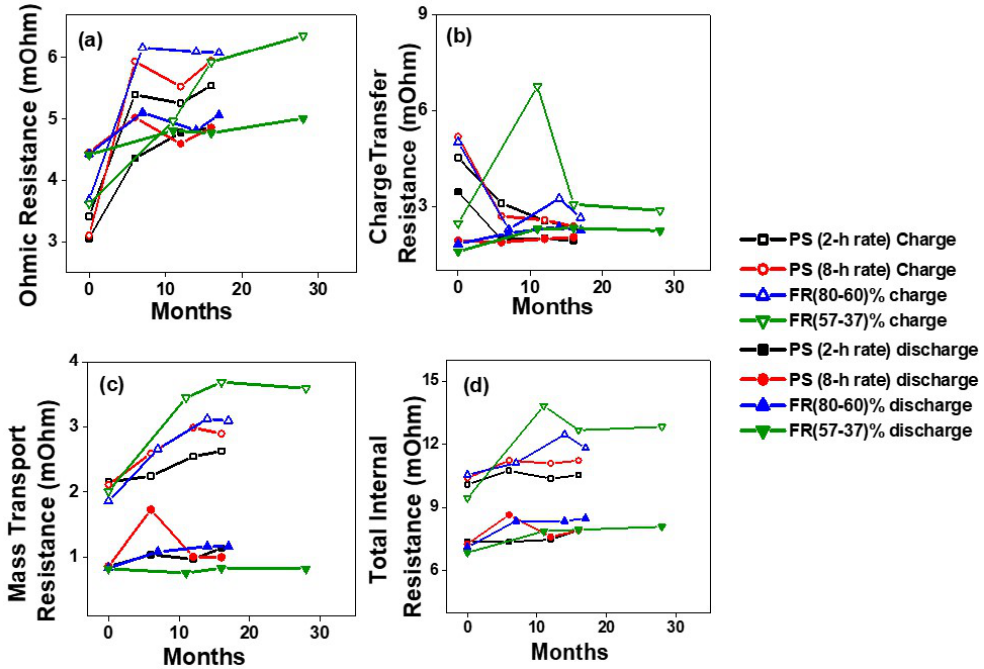
Figure 7. Resistance vs. elapsed test duration ( a ) ohmic, ( b ) charge transfer, ( c ) mass transport, ( d ) total.